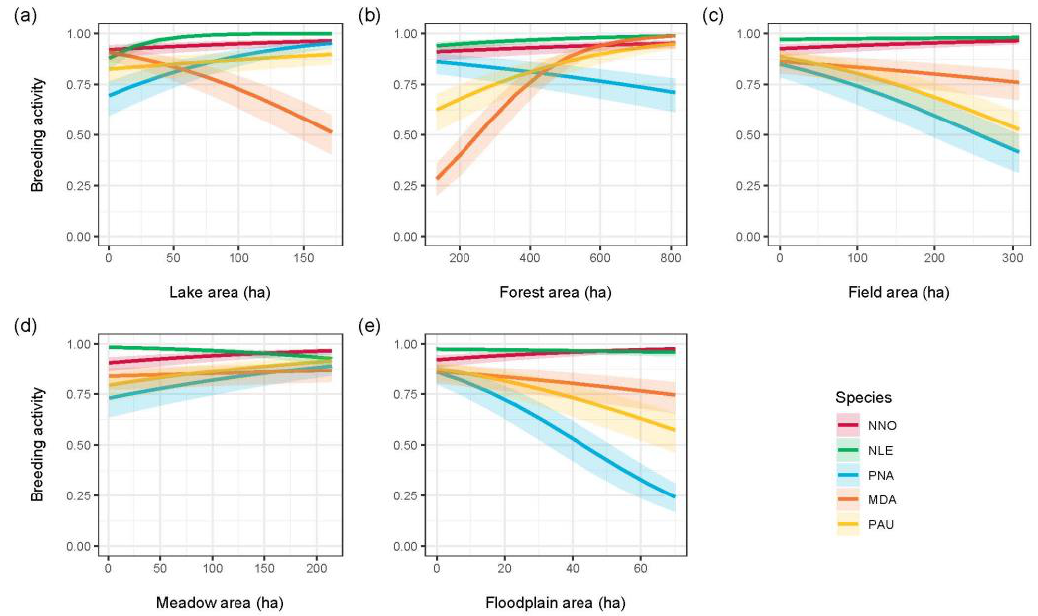
Figure 12. The probability of breeding activity of the five selected bat species as a function of the area of different land cover types. The solid lines represent predicted effects of the area of respective land cover types, with the shaded regions reflecting 95% CI.